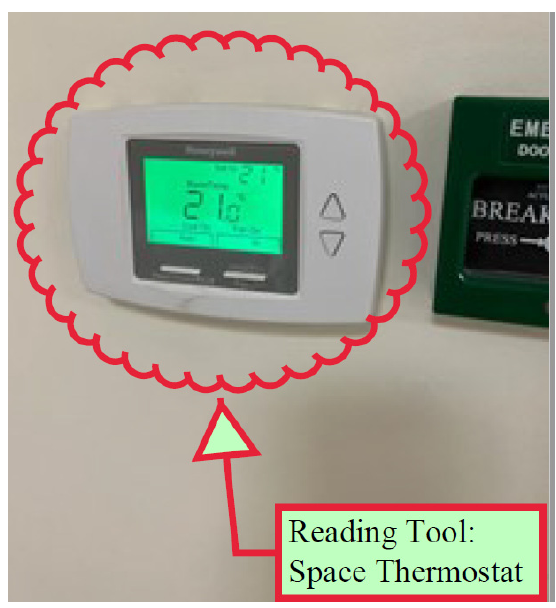
Figure 7. Terminal Unit Reading Tool.